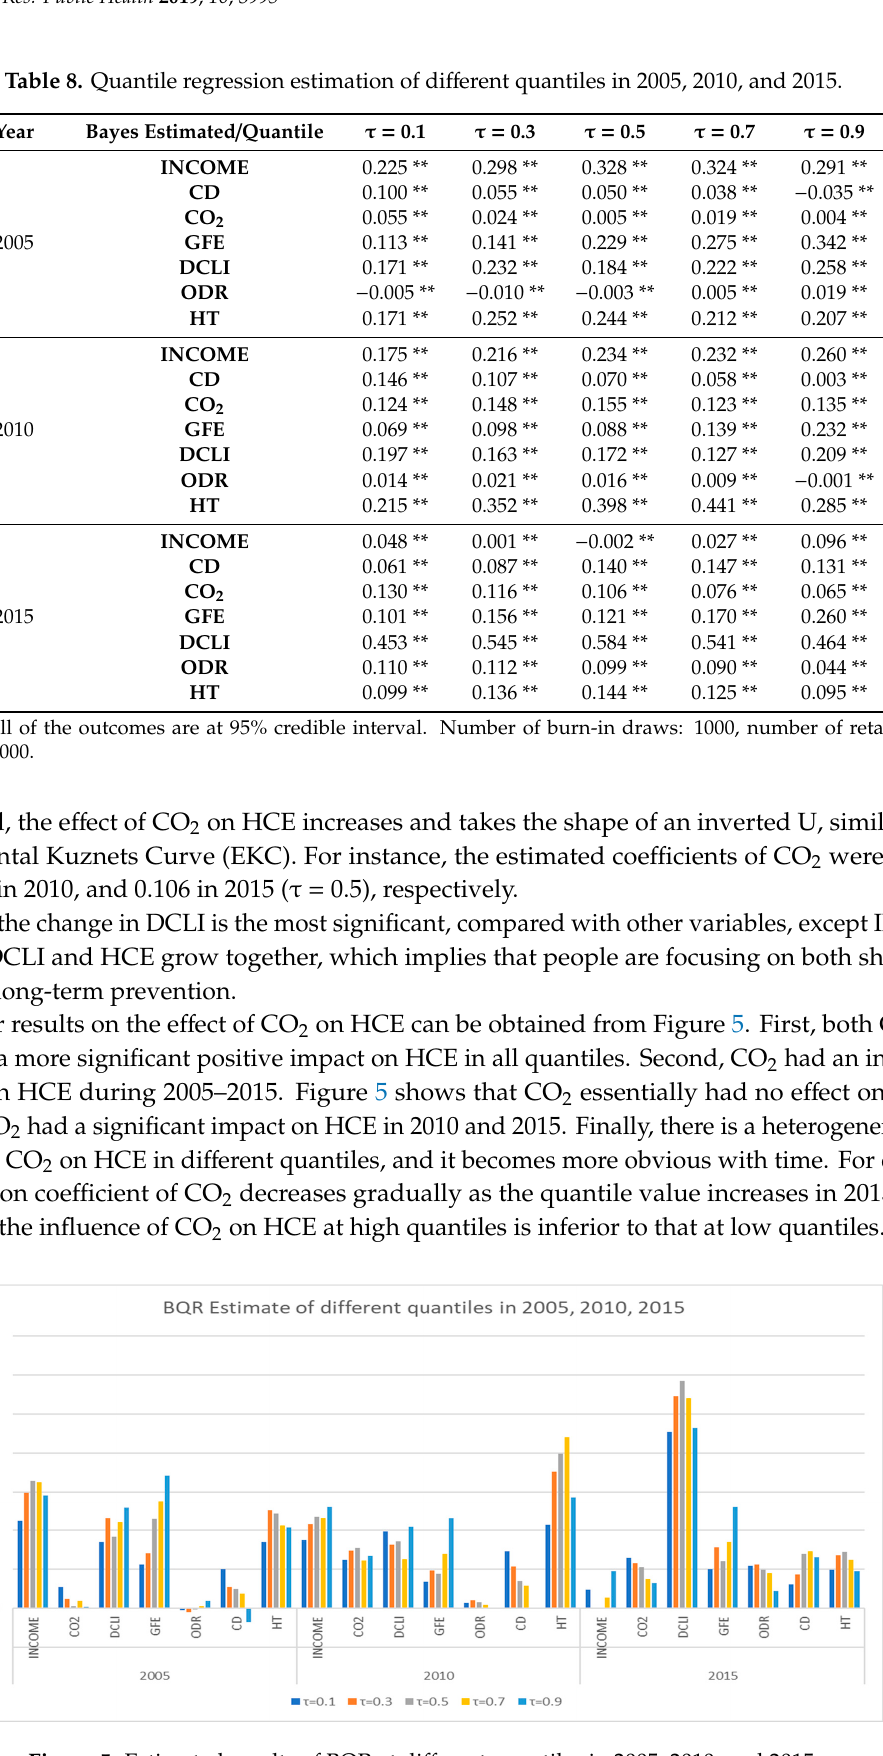
Figure 5. Estimated results of BQR at different quantiles in 2005, 2010, and 2015.